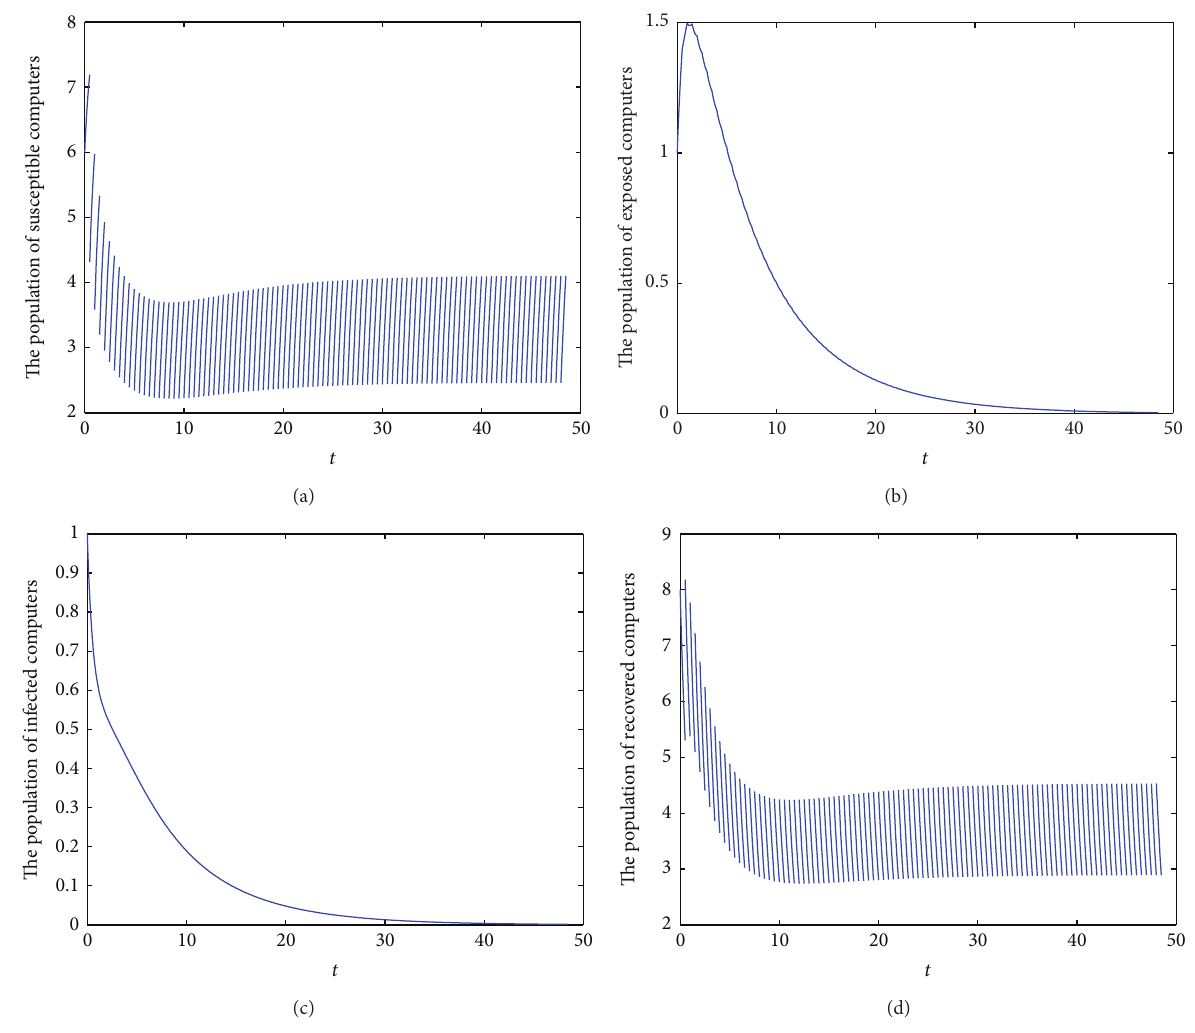
Figure 3: Global attractivity of virus-free periodic solution of